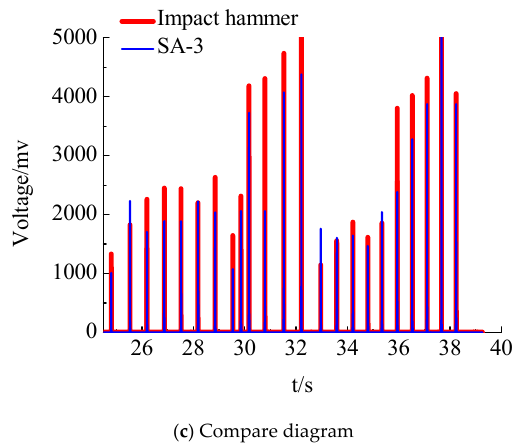
Figure 6. The waveform of the output voltage.